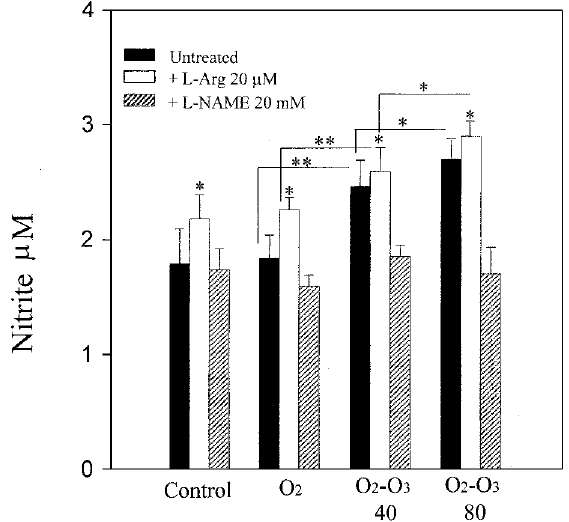
FIG. 2. Production of nitrite by HUVECs, measured after 24h incubation, after addition of normal human serum either oxygenated or ozonated (at 40 and 80 m g/ml). Effects of addition of L-arginine and L-NAME. The data are presented as the arithmetic mean ±SD of 6 different experiments.